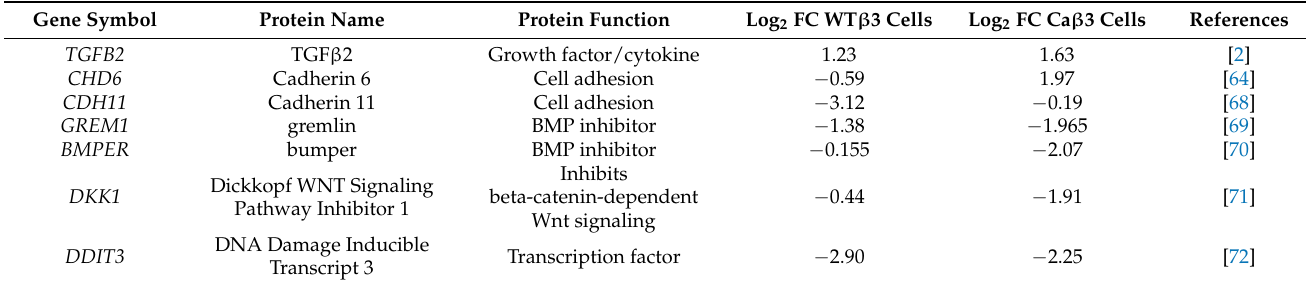
Table 3. Differentially expressed genes in WT β 3 and/or CA β 3 cells that are associated with IOP regulation. Log 2 FC values were reported in DGE analysis using